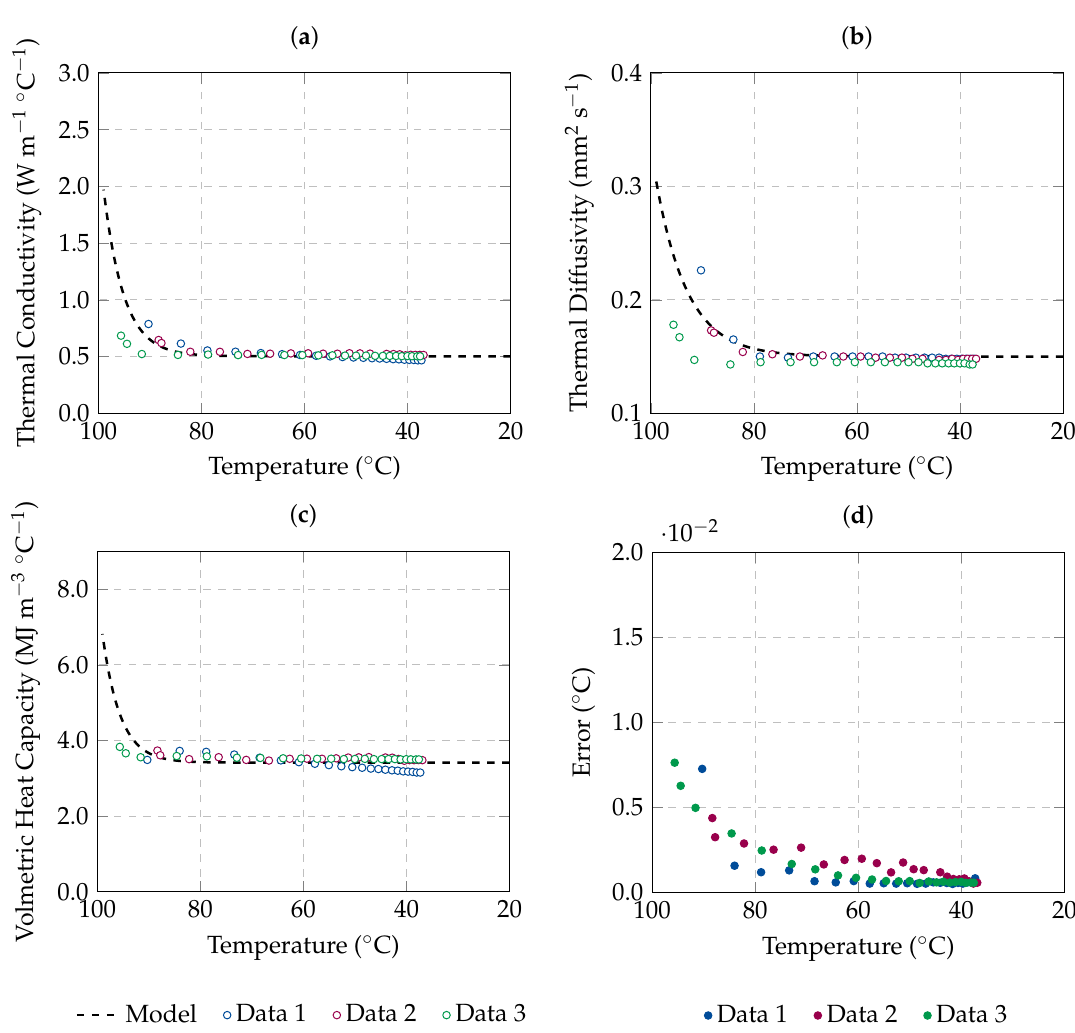
Figure 4. Thermal properties of ex vivo ovine liver as a function of the decreasing temperature: ( a ) thermal conductivity, ( b ) thermal diffusivity and ( c ) volumetric heat capacity. Raw data measured during the cooling of each sample are reported; their nominal associated uncertainty is 10%, which corresponds to the device accuracy. The best fit model described in Table 2 is also reported by a dashedline. The estimated error of how well the least square model fits the data is reported in ( d